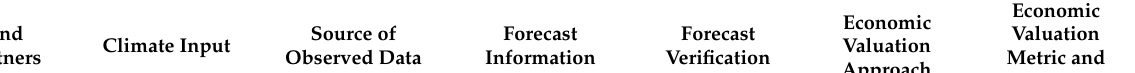
Table 1. Overview of the SECLI-FIRM case studies from the perspective of value-add